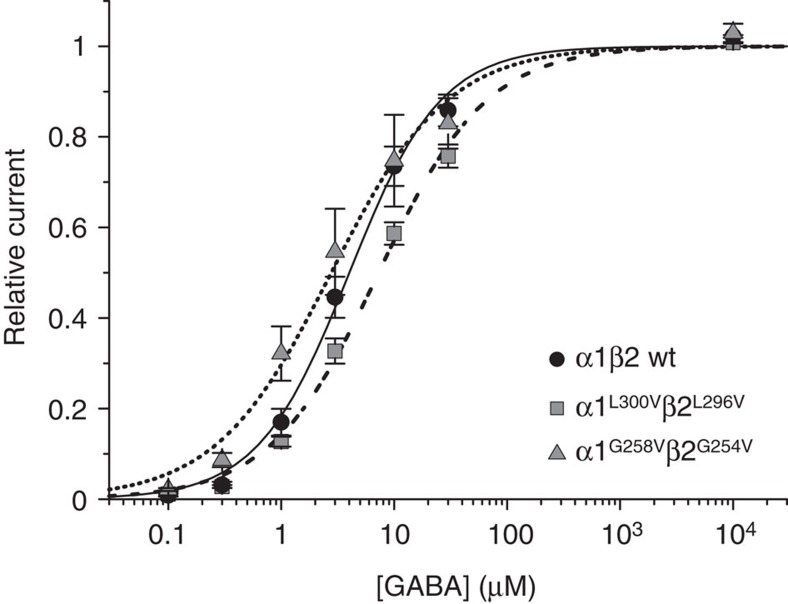
Effects of mutations α1L300Vβ2L296V and α1G258V β2G254V on GABA sensitivity.GABA concentration–response curves for wild-type (wt) α1β2 (EC50=4.1±0.7 μM, nH=1.08±0.07, n=6), α1L300Vβ2L296V (EC50=7.3±0.9 μM, nH=0.91±0.02, n=5) and α1G258V β2G254V receptors (EC50=3.0±0.9 μM, nH=0.89±0.19, n=5). Error bars are s.d.